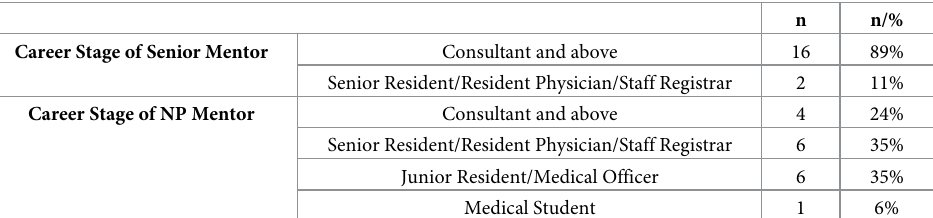
Table 5. Mentor’s stage of